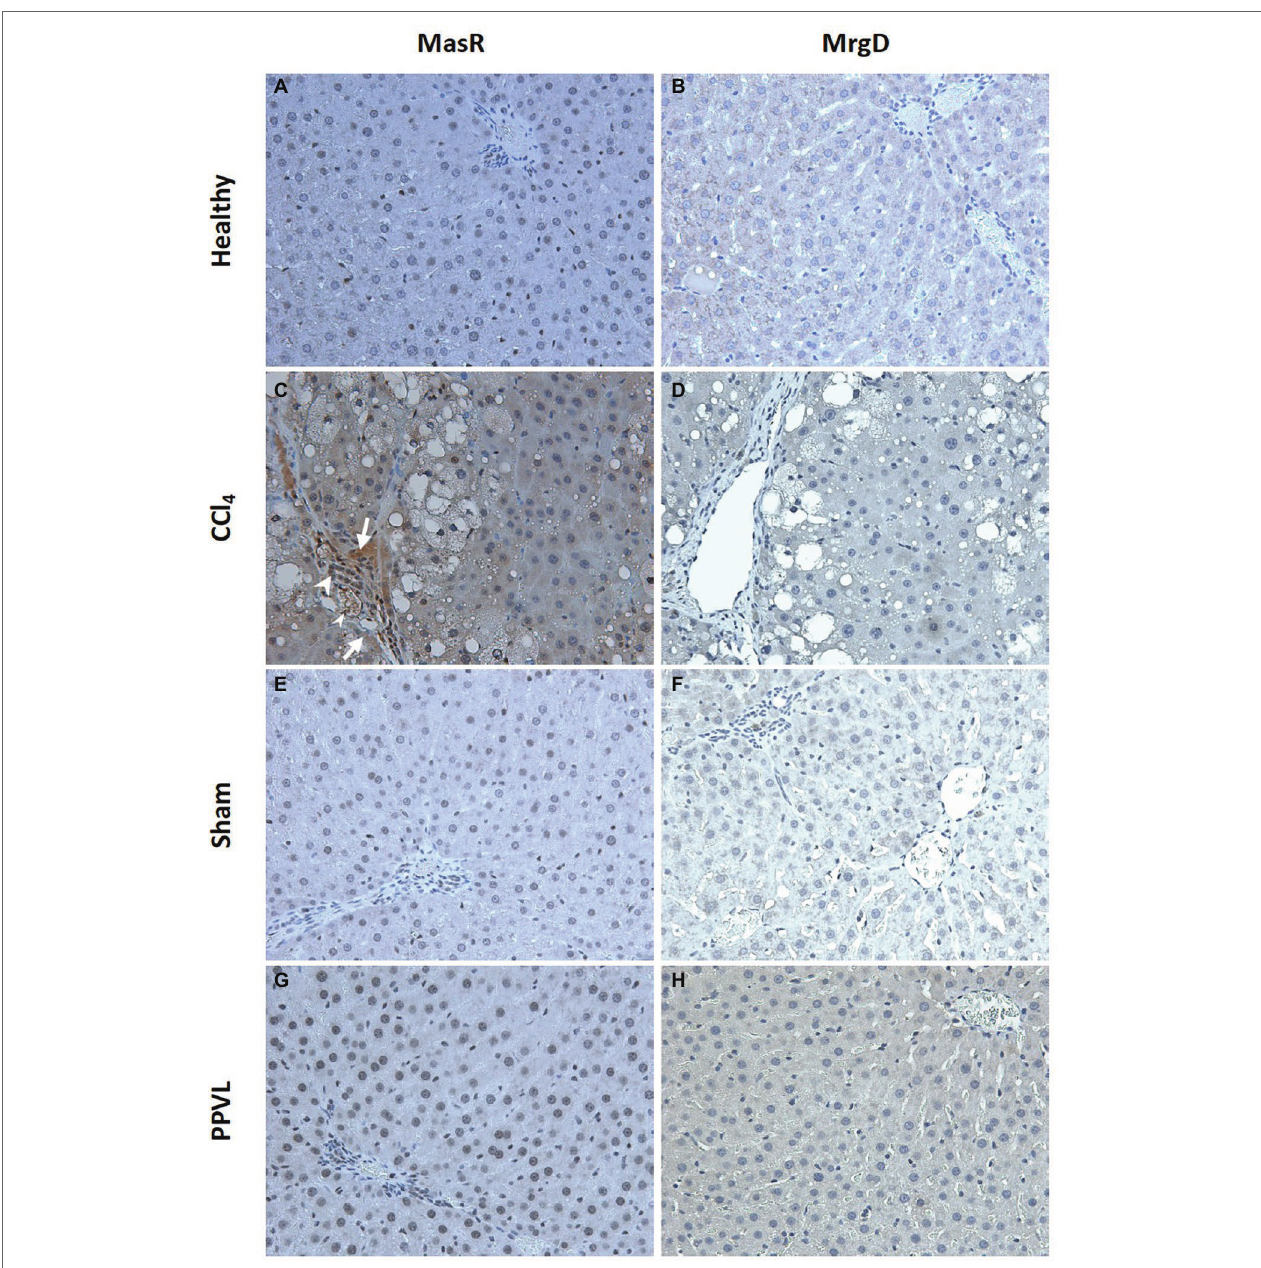
FIGURE 10 | Immunohistochemical localization of MasR (left column) and MrgD (right column) in the liver. MasR (C) and MrgD (D) staining of CCl 4 livers were compared with those of healthy control livers ( A,B , respectively). Note that in cirrhotic livers (C) , there was strong positive staining for MasR in liver sinusoids (arrow) which is consistent with the localization of hepatic stellate cells and/or liver sinusoidal endothelial cells. Also note that positive staining for MasR in bile duct epithelial cells (arrow head-large) and hepatic arterioles (arrow head-small) in the cirrhotic liver. However, there was no positive staining for MrgD in the cirrhotic liver (D) . Livers from PPVL rats showed no positive staining for both receptors (G,H) compared to the controls (E,F) . Original images were captured at the X20